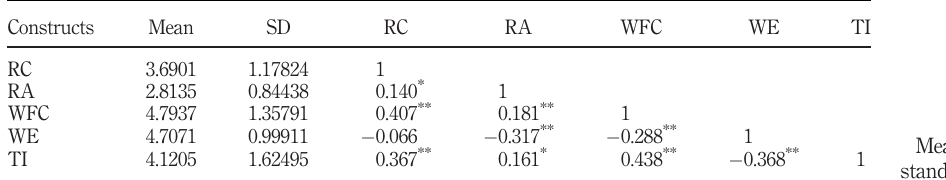
Table 2. Means (M